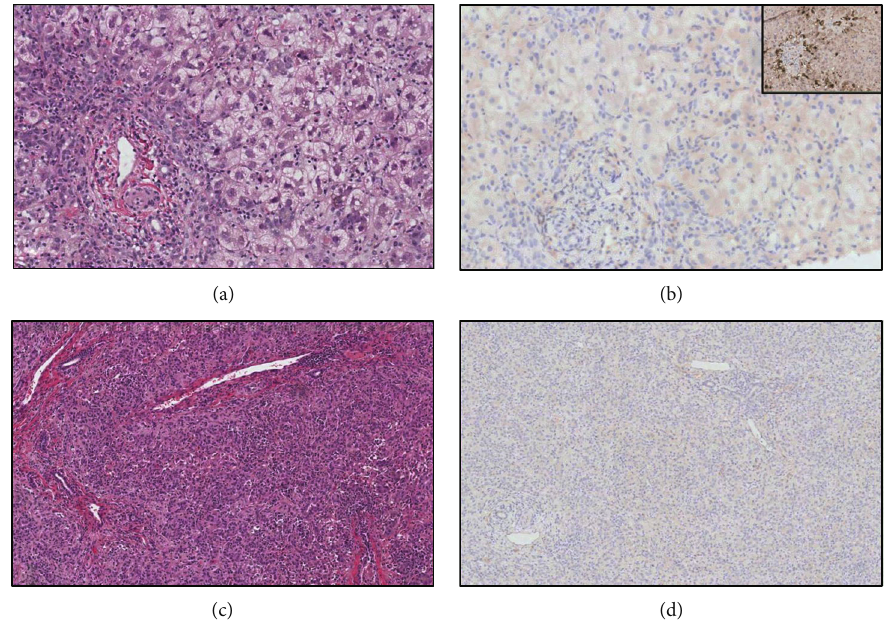
Figure 1: Liver biopsy (a, b) and explanted liver (c, d) show marked hepatitis that demonstrates progression from the biopsy time point to the explant. Panel a (Hematoxylin and Eosin) shows marked hepatitis with swollen hepatocytes, compared to the explant (panel c, Hematoxylin and Eosin), where most of the swollen hepatocytes are no longer visible while active in fl ammation persists. In both samples, adenovirus immunohistochemistry was negative (panels b and d; inset shows positive control for adenovirus). (Original magni fi cation, panels a – d: 100 ×